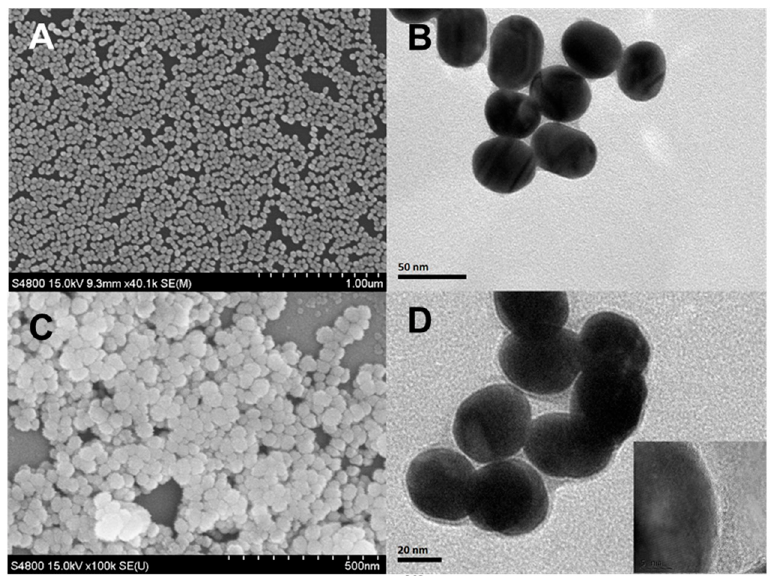
Figure 1. SEM images of the Au NPs ( A ) and Au@SNF NPs ( B ), TEM images of the Au NPs ( C ) and